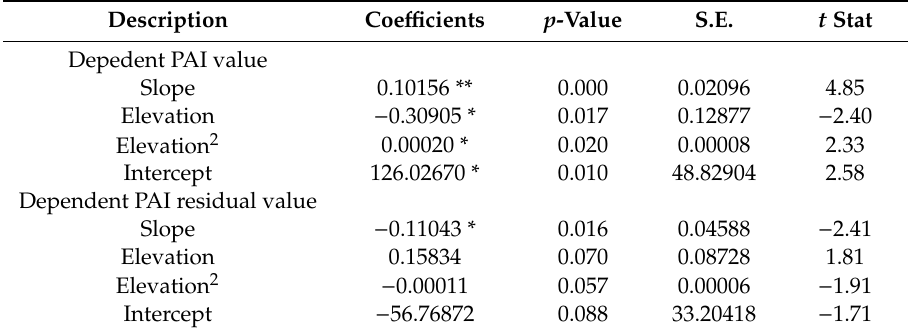
Table 2. E ff ects of topographic factors on PAI values and residual values using stepwise multiple regression